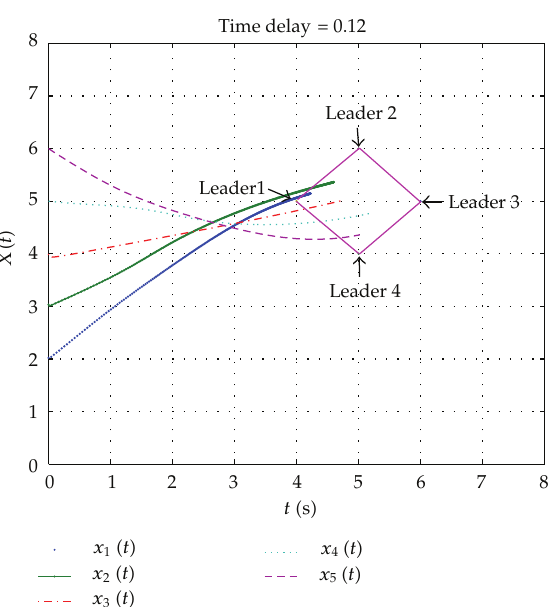
Figure 4: State trajectories of five follower agents and four leaders under the topology G 2 and time delay τ (cid:10) 0 . 12.